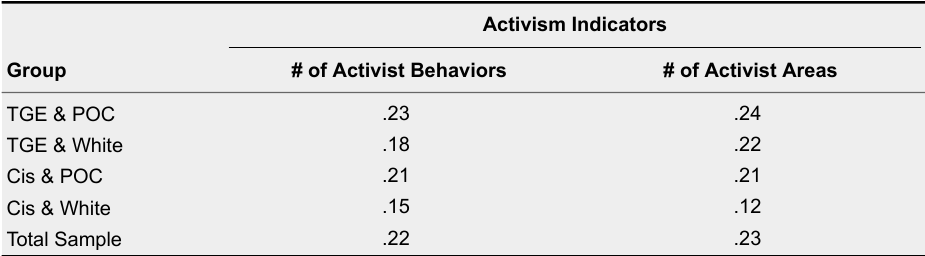
Correlations Between Discrimination and Activism